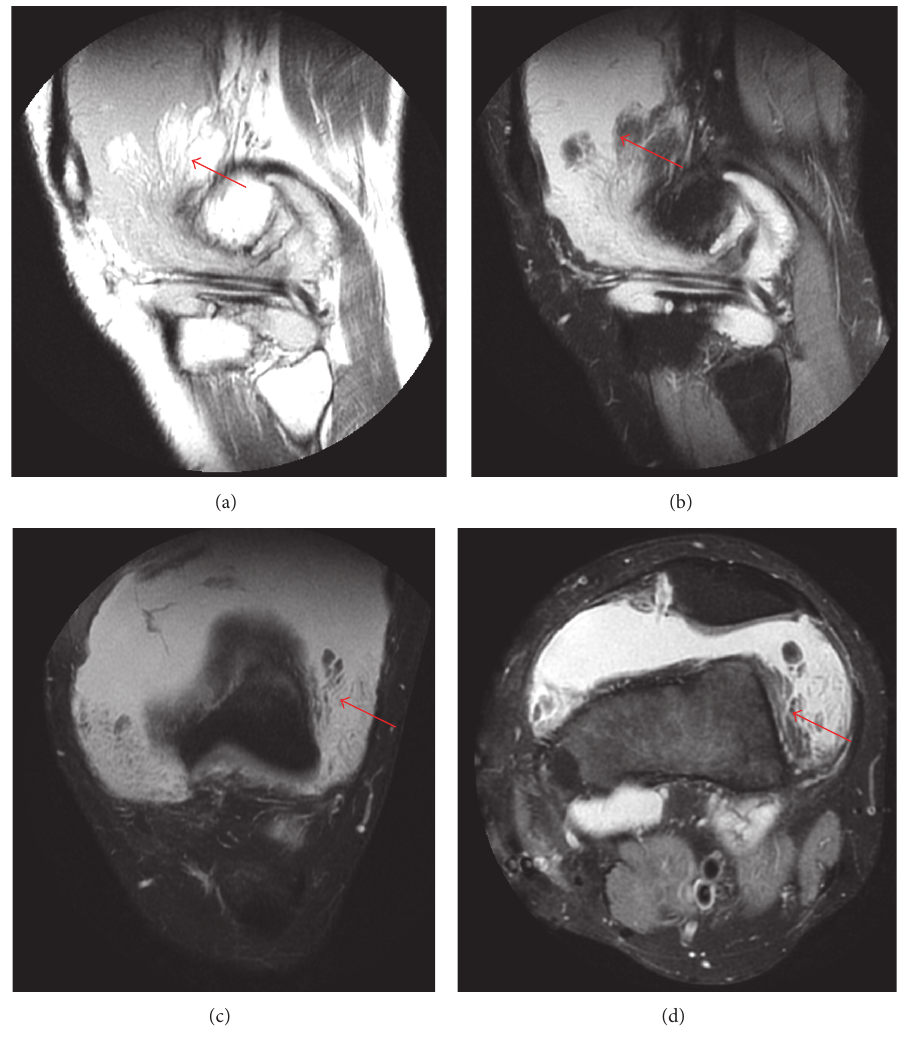
Figure 1: MRI of a 22-year-old male patient with lipoma arborescens of knee joints. Sagittal noncontrast T1 (b), weighted image, showed high signal intensity frond like synovial thickening in the suprapatellar bursal region (arrow) with joint effusion. GE HDesigna 3.0 Tesla magnetic resonance imaging system TR-737ms TE-9.3ms 3.5 mm slice thickness with interslice gap of 1mm was used. Sagittal (a), coronal (c), and axial (d) fat suppressed proton density images revealed complete suppression of signal intensity of villous projections (arrow) in suprapatellar bursal region. GE HDesigna 3.0 Tesla magnetic resonance imaging system was used. Sagittal TR-2264ms TE-24ms 3.5 mm slice thickness with interslice gap of 1mm, coronal TR-2740 TE-24 3.5 mm slice thickness with interslice gap of 0.5mm, and axial TR-1956 TE-22.8 4mm slice thickness with interslice gap of